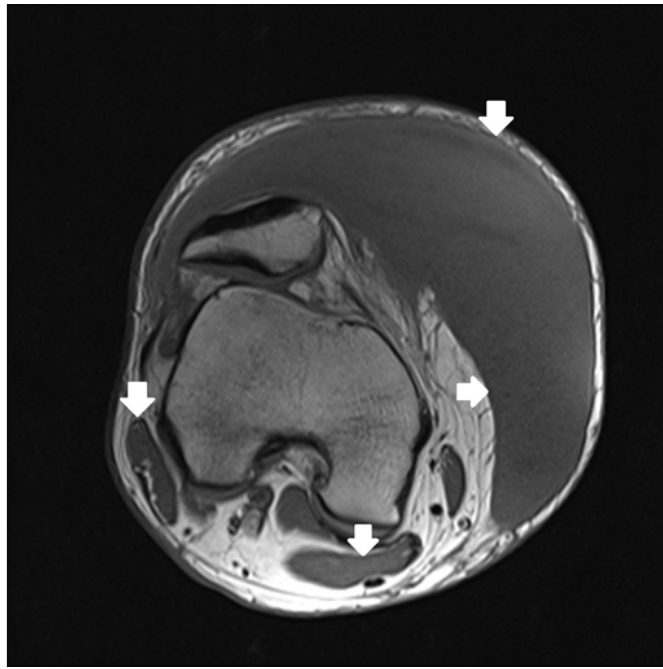
Figure 2b. Axial T1-weighted magnetic resonance imaging shows the lesion is isointense to